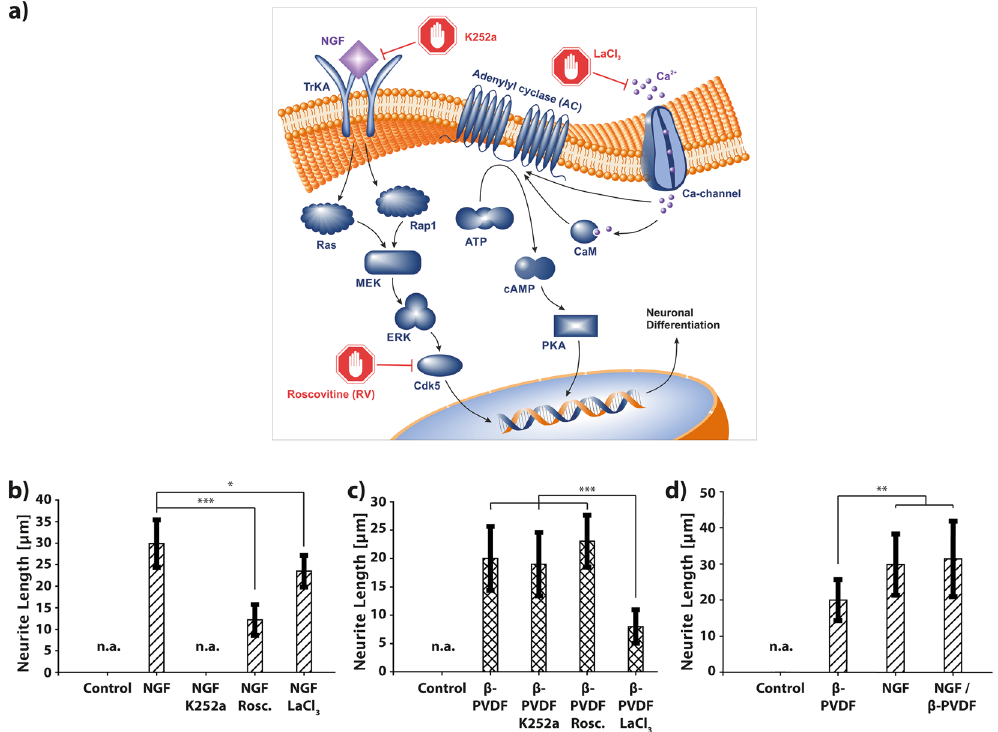
Figure 2. ( a ) Illustration of intracellular pathways affecting PC12 differentiation. On the left, the well-studied TrKA/Ras/MEK/ERK pathway. On the right, the proposed differentiation pathway induced by piezoelectric depolarization of the PC12 cell membrane. ( b , c ) Inhibitor experiments, showing average neurite length of PC12 cells stimulated by β -PVDF and US or NGF under the influence of the inhibitors K252a, LaCl 3 , and Roscovitine (RV). ( d ) Comparison of the stimulation effect of β -PVDF, NGF, and β -PVDF and NGF on the differentiation of PC12 cells. *** p < 0.001; n.a.: measured protrusions lower than 10 µ m – not considered as